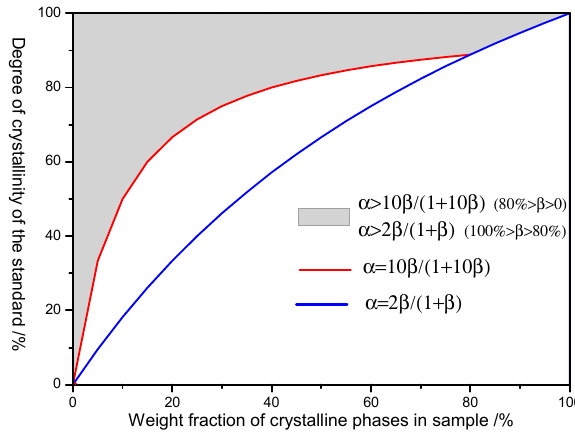
Figure 3. Accepted error-zone under the condition of ‘ ∆ AE ≤ 10% ∩ ∆ AE ≤